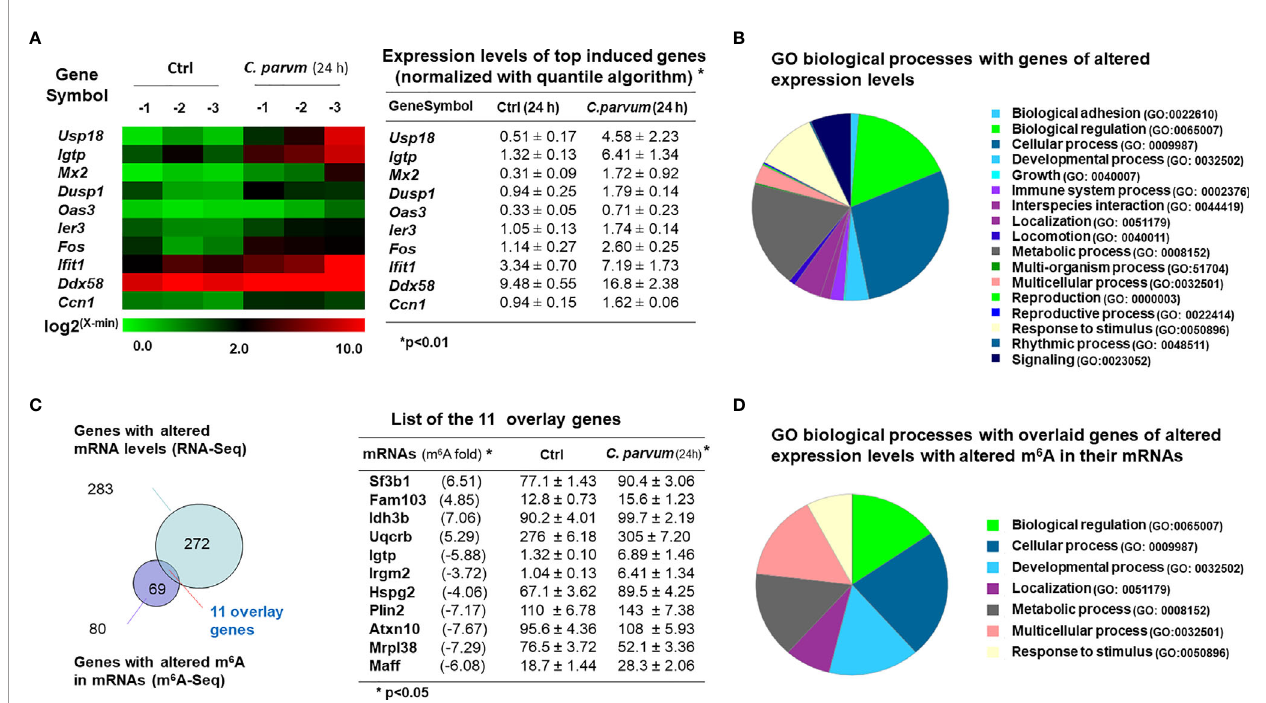
FIGURE 6 | mRNA expression pro fi le and its association with m 6 A levels in intestinal epithelial cells following C. parvum infection. (A) Heatmaps representing upregulation of the top 10 genes in IEC4.1 cells following C. parvum infection. IEC4.1 cells were exposed to C. parvum infection for 24 h followed by genome-wide RNA-Seq analysis. (B) Gene ontology (GO) analysis of genes whose expression levels were signi fi cant altered in IEC4.1 cells revealed by RNA-Seq analysis. (C) Comparison of genes whose expression levels were altered and these genes whose RNAs were with altered m 6 A levels in infected IEC4.1 cells. Only a small portion of the genes was overlaid. (D) Gene ontology (GO) analysis of the overlaid genes of altered expression levels and with altered m 6 A modi fi